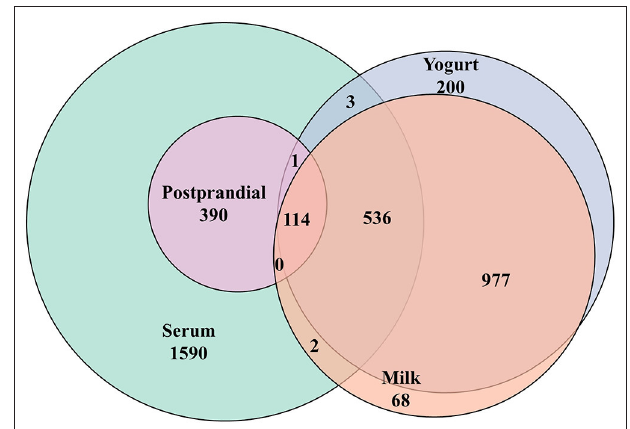
FIGURE 2 | Venn diagram summarizing the common metabolic features (LC-MS) detected in milk, yogurt, and the human serum before (fasting) and after (postprandial) the intake these two dairy